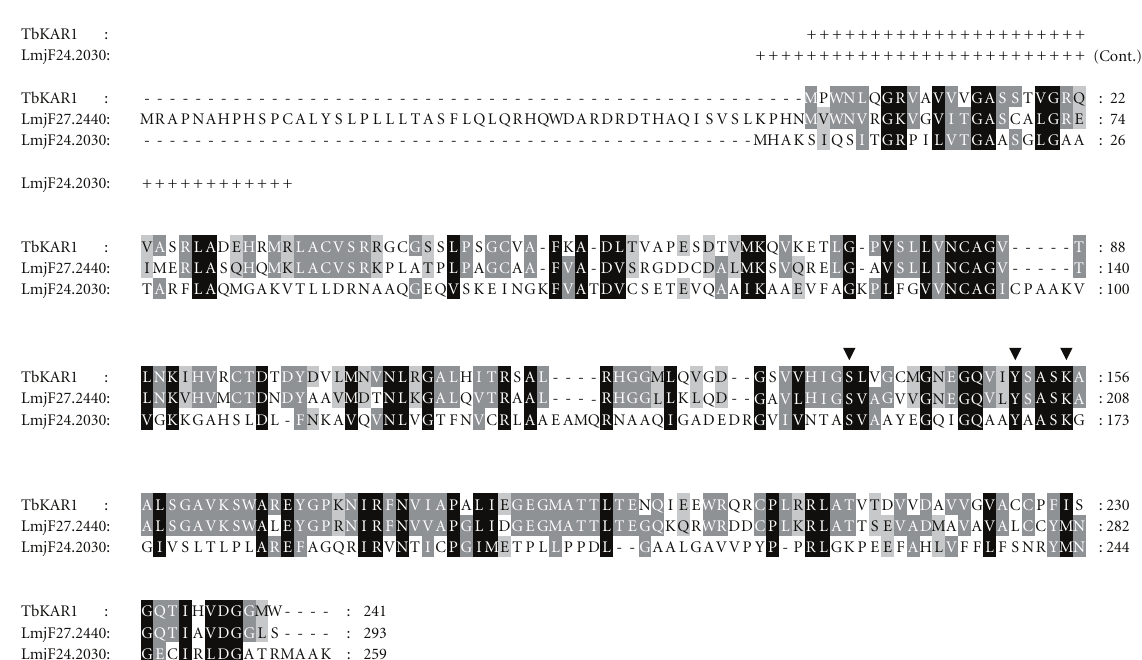
Figure 3: Similarity of L. major LmjF24.2440 and LmjF24.2030 to their T. brucei homologue, Tb KAR1. MitoProt predictions of cleaved mitochondrial leader sequences are indicated (+). Catalytic amino acid residues occurring in E. coli FabG are marked ( (cid:2) ). The accession number for Tb KAR1 was